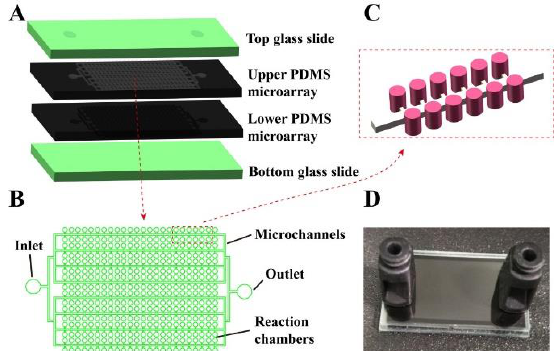
Figure 1. The double-deck microfluidic chip. ( A ) Schematic of the layered chip structure. ( B ) Schematic of microfluidic digital PCR (dPCR) chip. ( C ) Diagram of the details of the chip. ( D ) Photograph of the prototype device. The chip size is 35 mm × 20 mm.